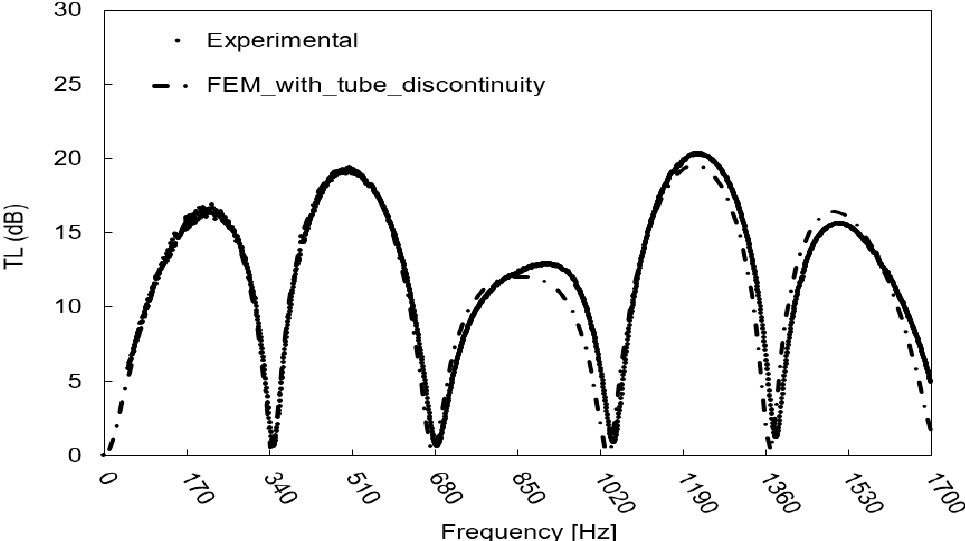
Figure 12. Comparison between experimental and FEM-simulated TL of the expansion chamber with tube discontinuity.